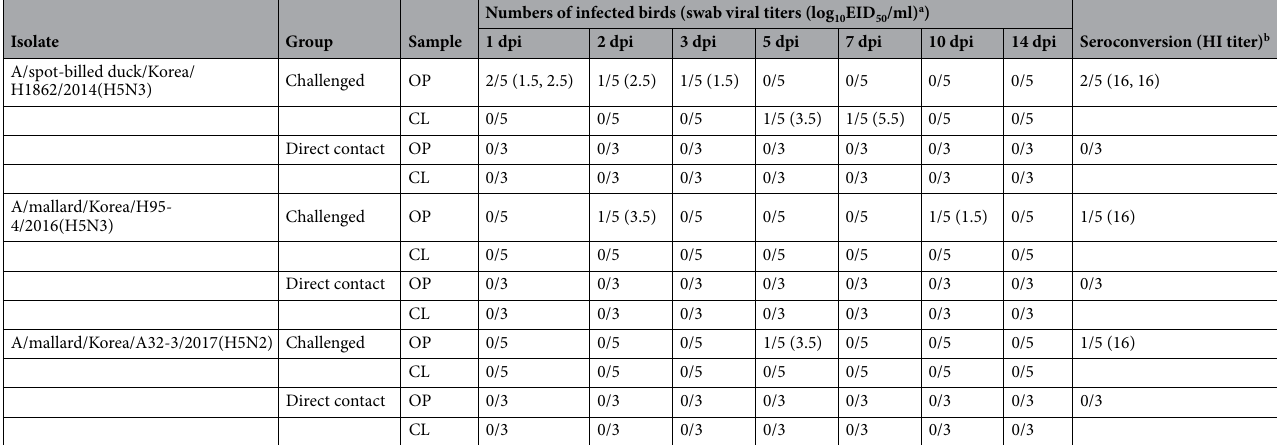
Table 3. Replication and transmission of representative H5 low pathogenic avian influenza viruses in 3-week- old specific-pathogen-free chickens. a Values shown are number of infected birds/number of inoculated birds in the challenge groups, and number of infected birds/number of naïve birds in the direct-contact groups. Values in parentheses are virus titers (log 10 EID 50 /ml). Mean viral titers from OP and CL swabs were calculated by the Reed and Muench method. b Sera were collected from chickens at 14 dpi. Seroconversion was confirmed by HI assay. Values shown are number of birds showing seroconversion/number in group. Values in parentheses are HI titer. CL, cloacal; dpi, days post-infection; EID 50 , 50% egg-infective dose; HI, hemagglutination inhibition; OP,